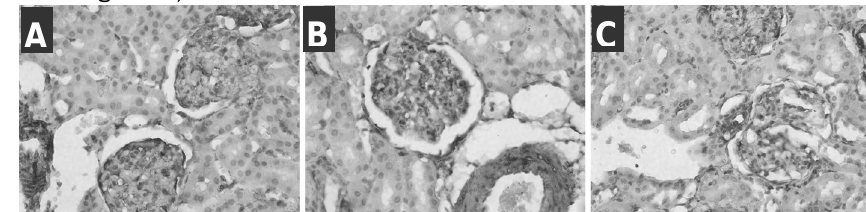
Figure 2. Immunohistochemistry analysis of MLCK was performed in glomerulus and renal tubule from control, streptozotocin-diabetes and insulin-treated rats. Immunohistochemistry analysis were